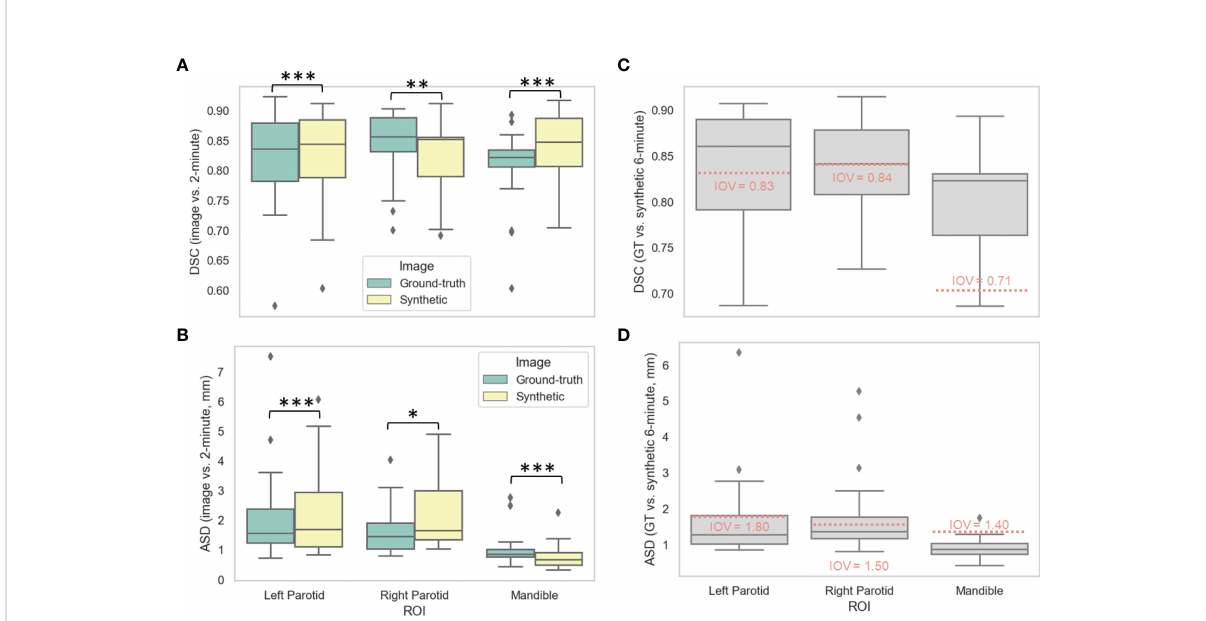
FIGURE 3 Auto-segmentation results. Auto-segmented organs at risk (left parotid gland, right parotid gland, and mandible) were generated on ground- truth ([GT], green) or synthetic (yellow) 6-minute images and compared against 2-minute images using the (A) Dice similarity coef fi cient (DSC) and (B) average surface distance (ASD). Segmentations generated on GT and synthetic images were then directly compared using the (C) DSC and (D) ASD. Stars above plot indicate paired two one-sided t-tests (equivalence test) level of signi fi cance: ns: p > 0.05; *: 0.005 < p <= 0.05; **: 0.0005 < p <= 0.005; ***: p<= 0.0005. Red dotted lines correspond to median interobserver variability (IOV) metric values derived from clinical experts from previous literature investigating 2-minute